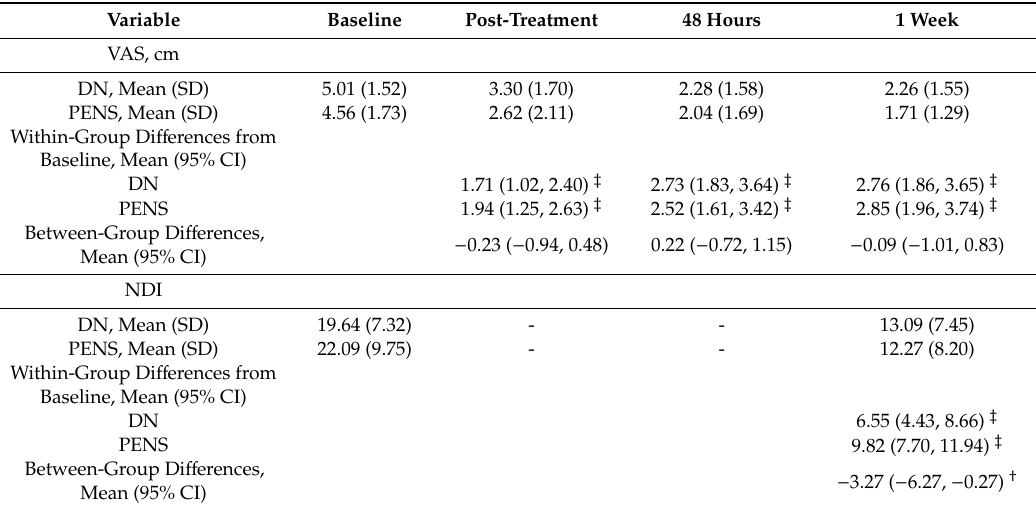
Table 2. Pain and disability di ff erences within- and